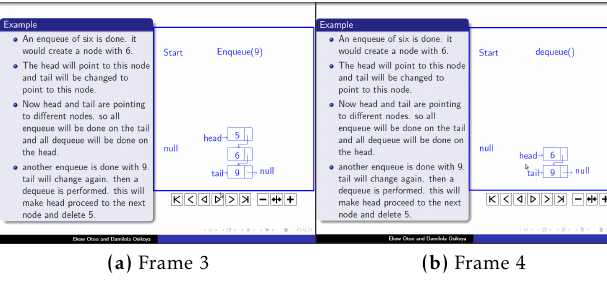
Figure 8. Queue Implementation(Linked list)